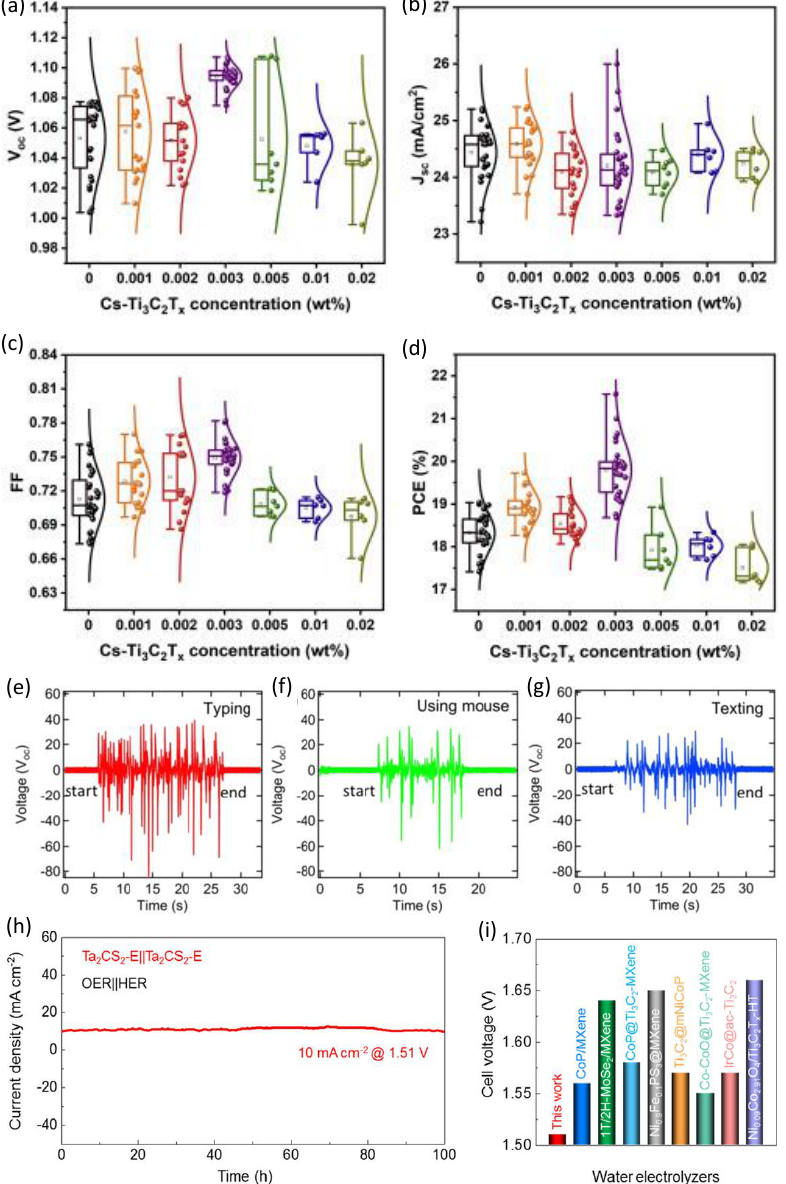
Figure 13. Recent applications of green MXenes in energy harvesting devices ( a – d ) solar cells [162], ( e – g ) nanogenerator [163], and ( h – i ) water splitting for hydrogen production [164].